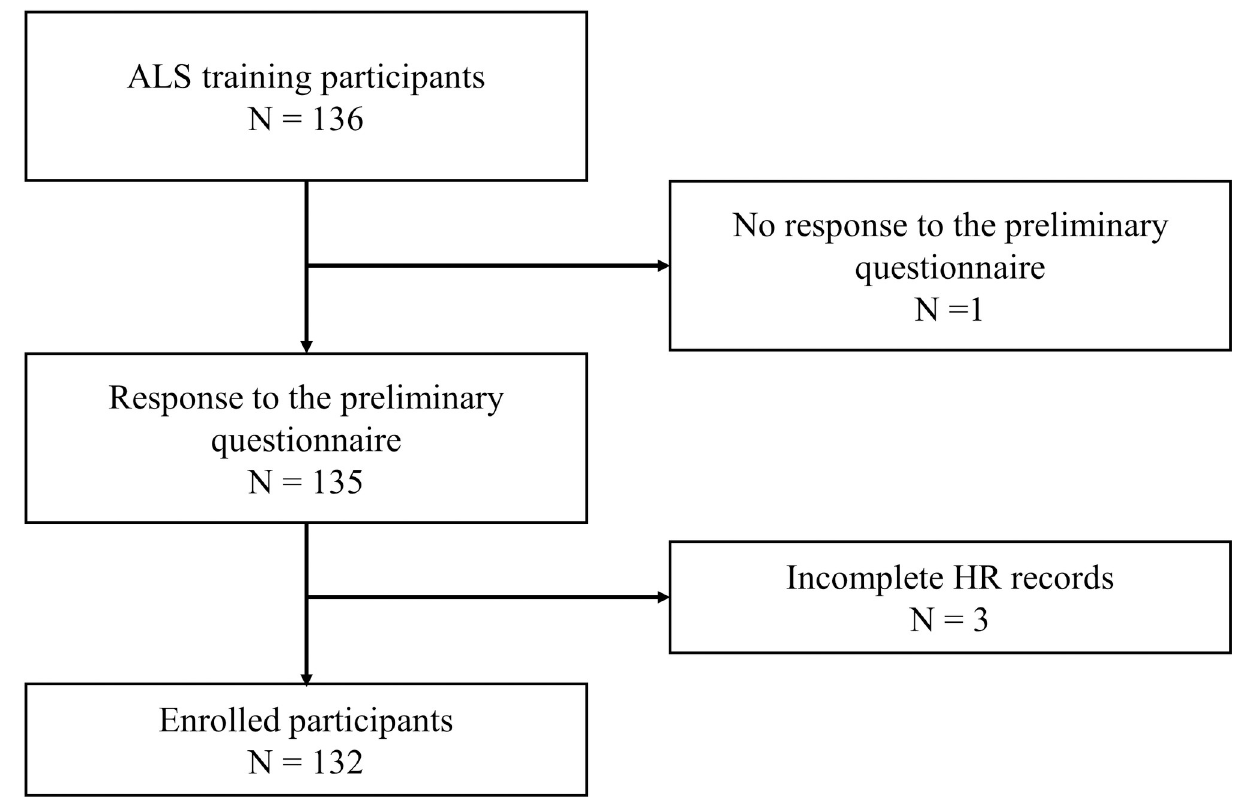
Fig 1. Flow diagram of participant